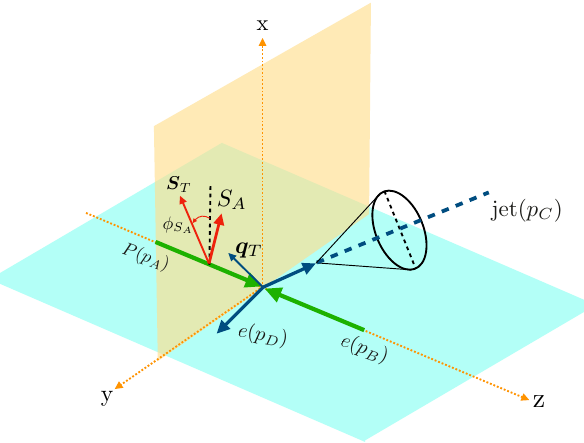
Figure 1 . Back-to-back electron and jet production in electron-proton collision, where S A indicates the spin of the incoming proton and q T is the imbalance momentum between the outgoing electron and the final-state